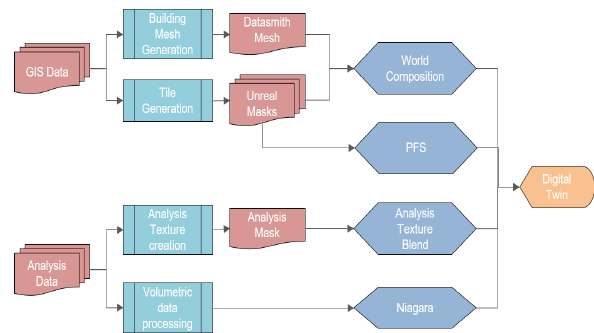
Figure 1 . Data pipeline for the procedural digital twin generation